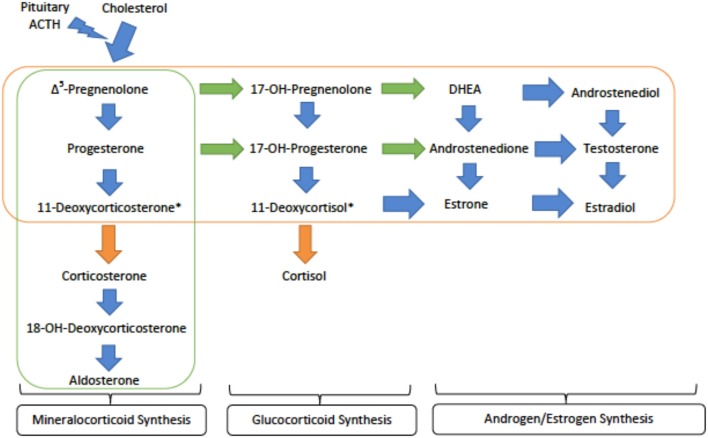
An overview of the steroid synthesis pathways and the enzyme deficiences that lead to congenital adrenal hyperplasia (CAH) types IV and V. The orange arrows show the activity of 11β-hydroxylase (deficient 1 in type IV) while the orange rectangle surrounds the steroid hormones still produced in CAH type IV. The green arrows denote the activity of 17α-hydroxylase (deficient in type V) while the green rectangle encircles those hormones produced in CAH type V. ACTH - adrenocorticotropic hormone; DHEA - dihydroepiandrosterone. *These metabolites are active at the mineralocorticoid receptor and are important in generating hypertension.